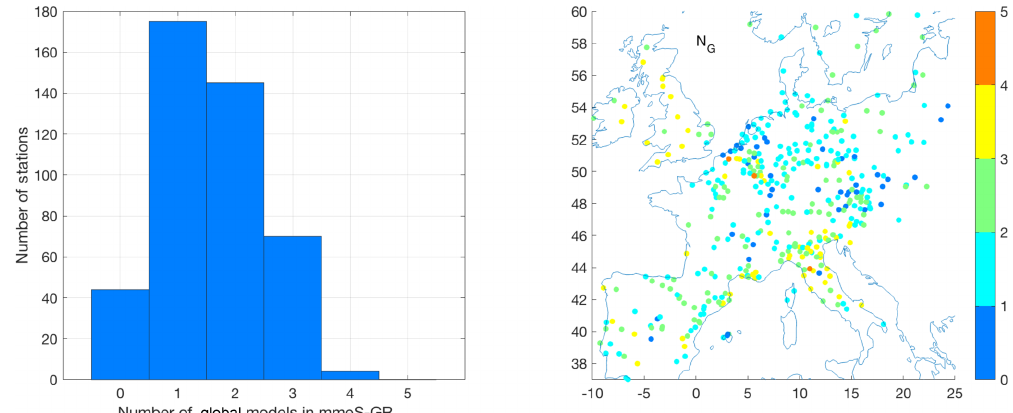
Figure 9. Contribution of Global models to mmeS_GR and its spatial representation.